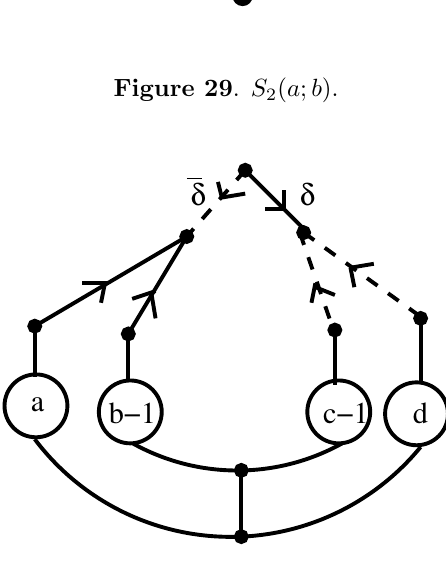
Figure 30 . R 2 ( a ; b j c; d